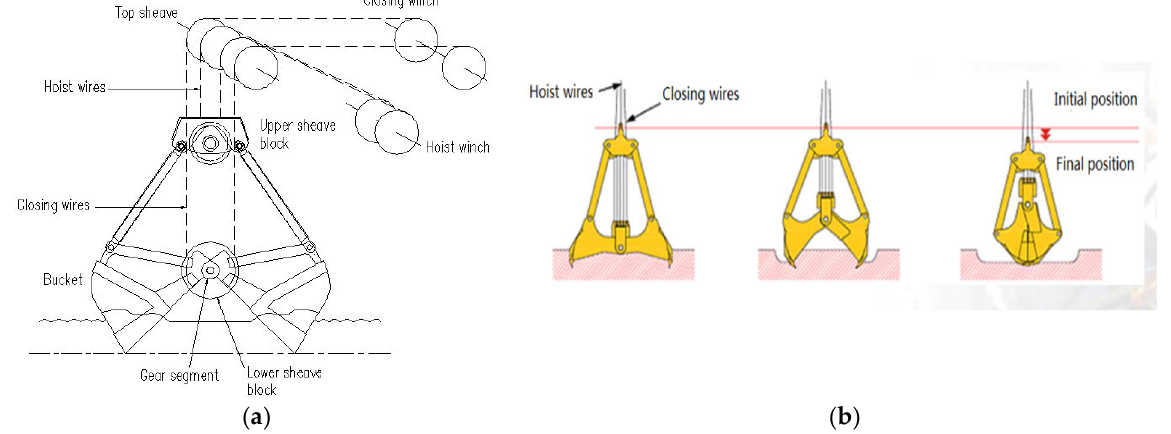
Figure 1. ( a ) Structural components of clamshell grab; ( b ) Closed track of grab flat digging. Under normal and flat digging conditions with a grab dredger, the digging curve is different, depending upon the conditions. In the normal digging state, the digging curve is steep, while, in the flat digging state, the digging curve is smooth. In order to achieve